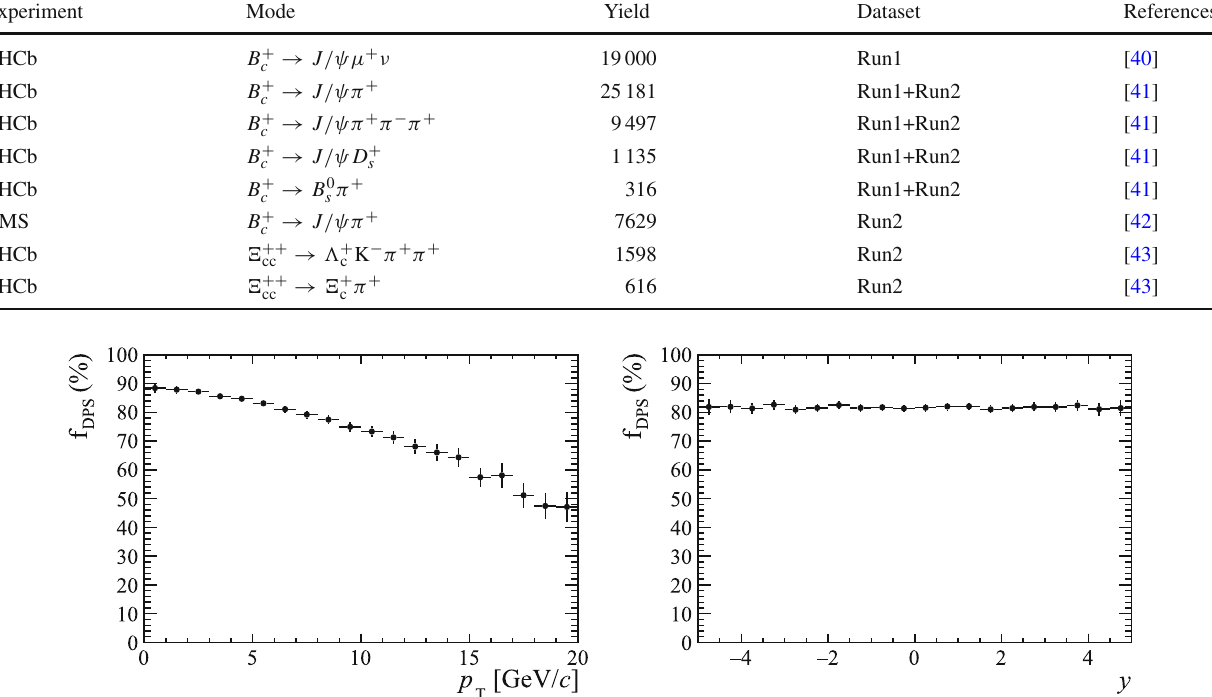
Fig. 27 Fraction of B + c decays predicted to be produced by DPS processes as a function of (left) p T and (right) rapidity in simulations samples produced by Pythia